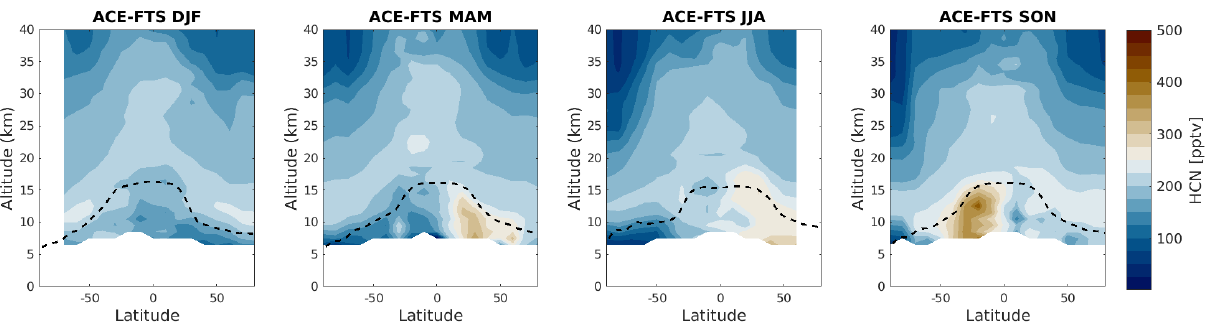
Figure 1. Latitude–height cross sections of ACE-FTS HCN zonal mean profiles (pptv) in 10 ◦ latitude bins for four seasons, December– February (DJF), March–May (MAM), June–August (JJA), and September–November (SON), from December 2008 to November 2009. The dashed black lines show the season-averaged location of the thermal tropopause (Maddox and Mullendore, 2018) based on ECMWF ERA-Interim reanalyses for the same periods. Table 1. Ground-based NDACC FTIR observation sites used in this study. Site Coordinates Altitude